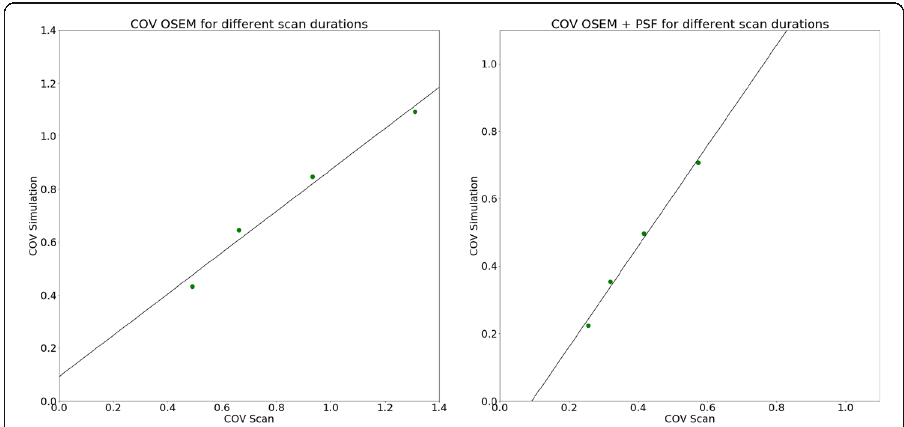
Fig. 4 COV values in the background compartment of the NEMA image quality phantom of the simulation against the COV values of the scan for OSEM (left) and OSEM+PSF (right)